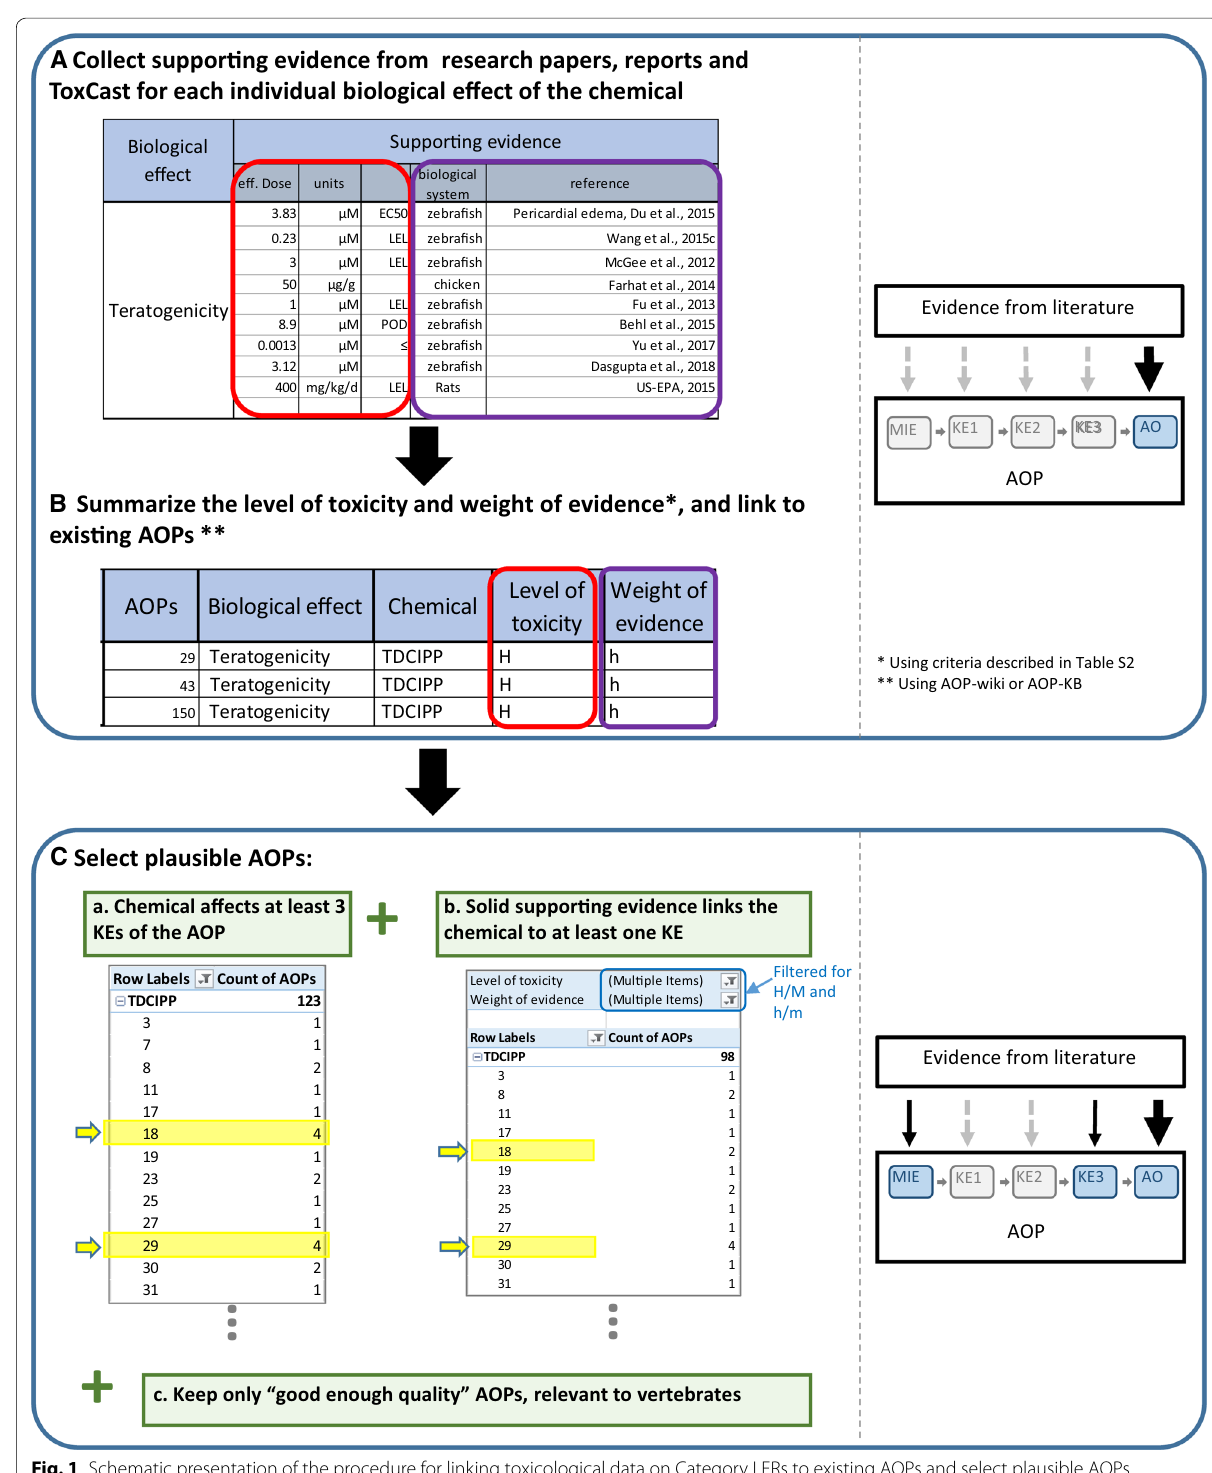
Fig. 1 Schematic presentation of the procedure for linking toxicological data on Category I FRs to existing AOPs and select plausible AOPs, an example for TDCIPP. The 3 main steps of the procedure are detailed and illustrated with extracts from Excel tables ( a , b ) and pivot tables ( c ) generated from the table shown in b . Full data corresponding to table shown in a are presented in Additional file 4: Tables S5. Schemes on the right illustrate the goal of steps A and B (linking evidence from literature to individual MIE/KE/AO and corresponding AOPs), and then c (selecting plausible AOPs). Plain arrows indicate that some supporting evidence links the chemical to the MIE/KE/AO and the thickness of the arrow refers to the weight of evidence and level of